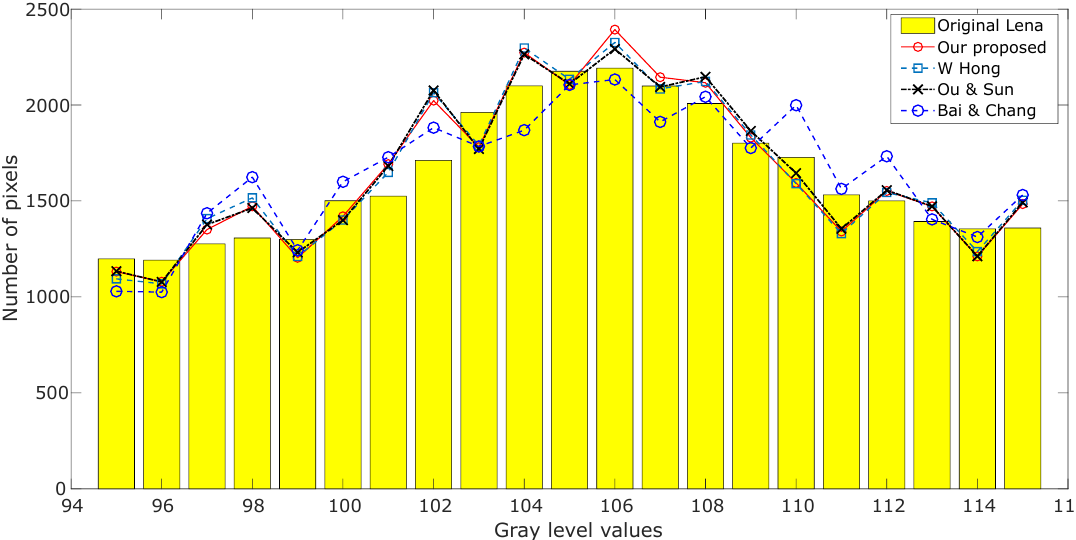
Figure 9. Compared histograms among the proposed method and other related methods with the Lena image when the number of hidden bits is